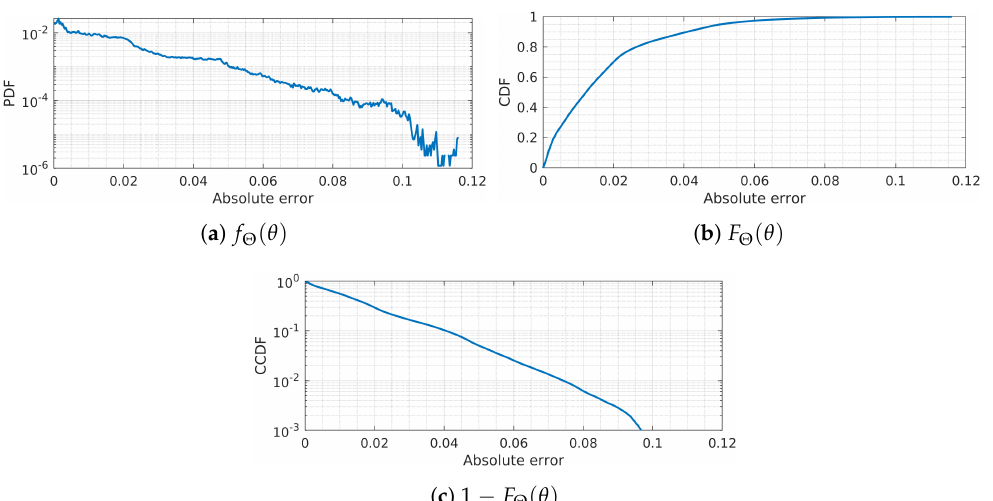
Figure 16. Distribution of the absolute errors behavior of all the performed simulations: ( a ) PDF, ( b ) CDF, and ( c )